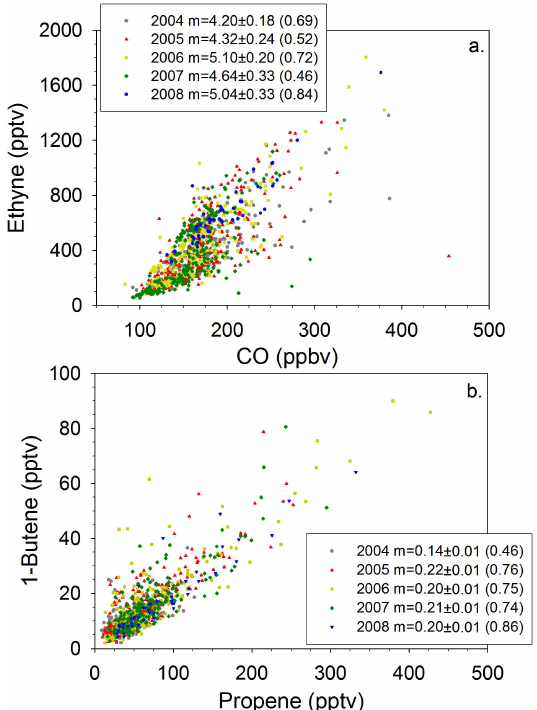
Fig. 6. Correlations ( m =slope ± standard error ( r 2 )) between (a) CO (ppbv) and ethyne and (b) propene and 1-butene for each year (2004, 2005, 2006, 2007, 2008).